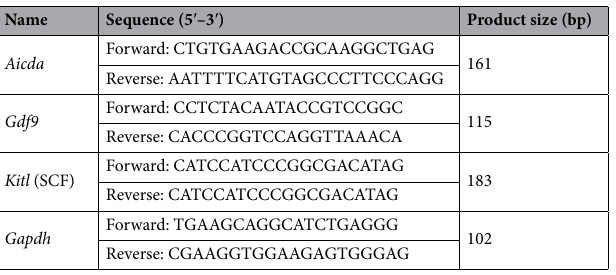
Table 1. Primers for quantitative-PCR. Gapdh glyceraldehyde-3-phosphate dehydrogenase, Kitl kit